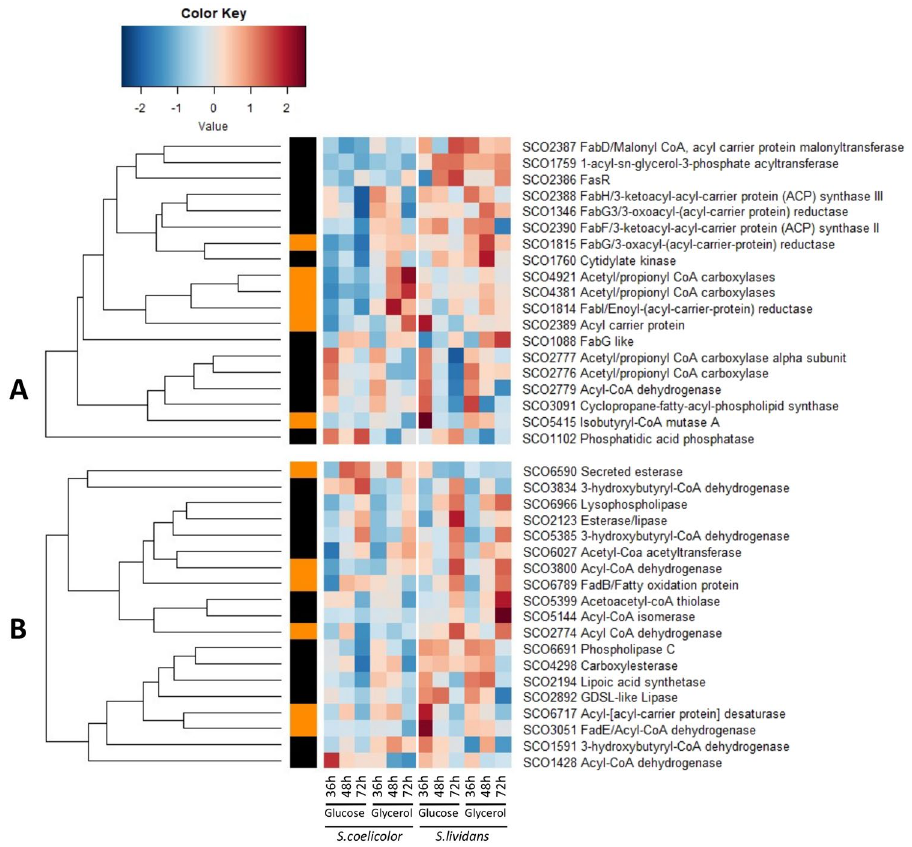
Figure 6. Independently generated heatmap representations of proteins belonging to lipid biosynthetic (A) and degradative (B) pathways with significant abundance change (ANOVA, adjusted p value < 0.05) between S. coelicolor (M145) and S. lividans (TK24) with either glucose or glycerol as main carbon source, for 36, 48 and 72 h. Protein identifiers are indicated as SCO numbers for both strains and by predicted functions. The quantification methods are displayed in the vertical bar indicating proteins quantified by Spectral Counting (orange) or XIC